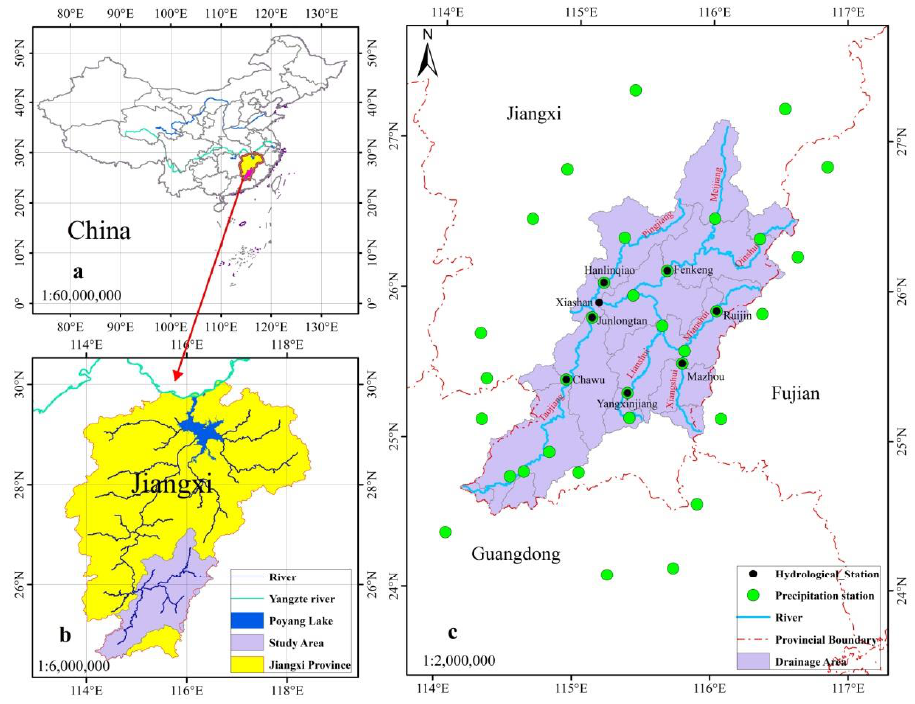
Figure 1. Location of study region and main hydrological stations in the Gongshui River.